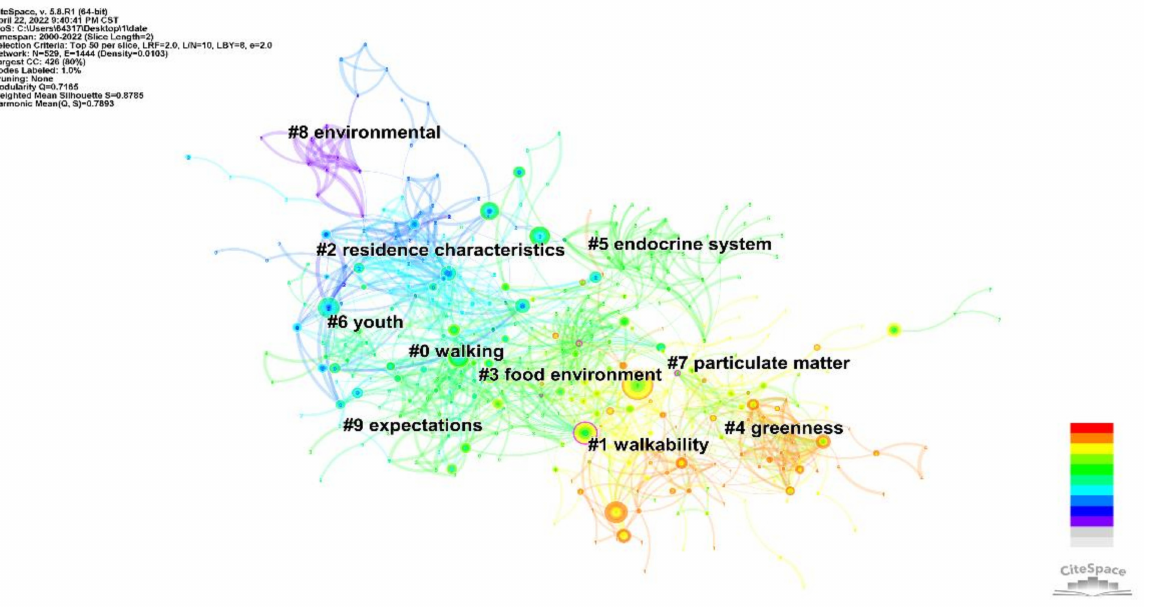
Figure 9. Knowledge map of literature